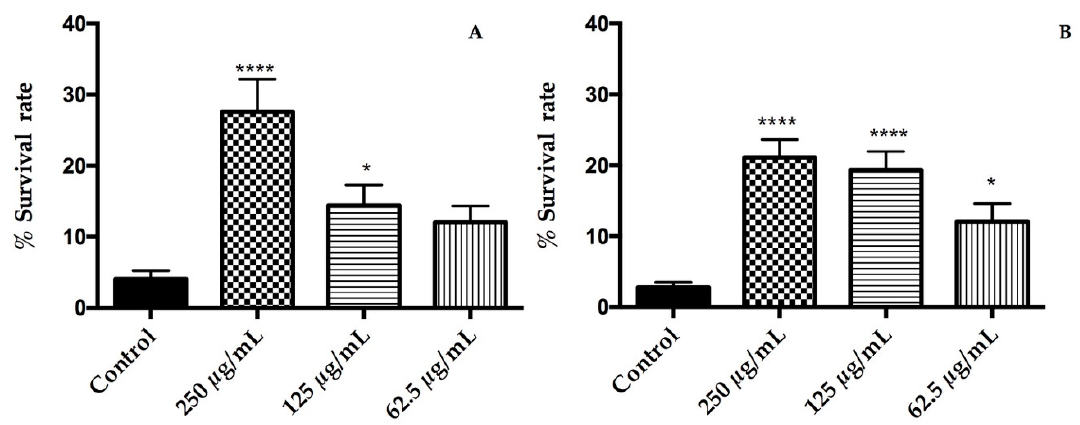
Figure 2. Effects of ( A ) orange cultivar and ( B ) yellow cultivar of T. erecta flowers extracts on the response to a lethal oxidative stress induced by juglone on C. elegans . Differences compared to the control group were considered significant at p < 0.05 (*) and p < 0.0001 (****).